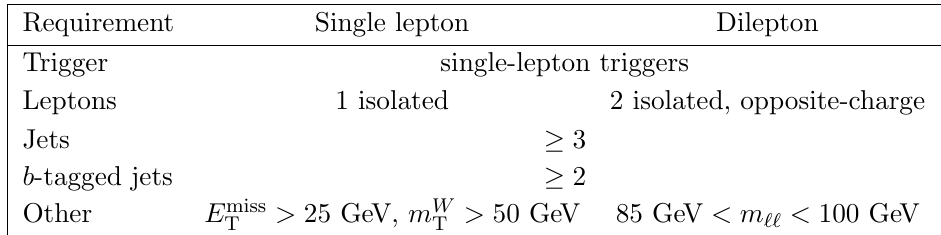
Table 1. Summary of requirements for the single-lepton and dilepton channels. Here m ‘‘ is the dilepton invariant mass in the ee and (cid:22)(cid:22)